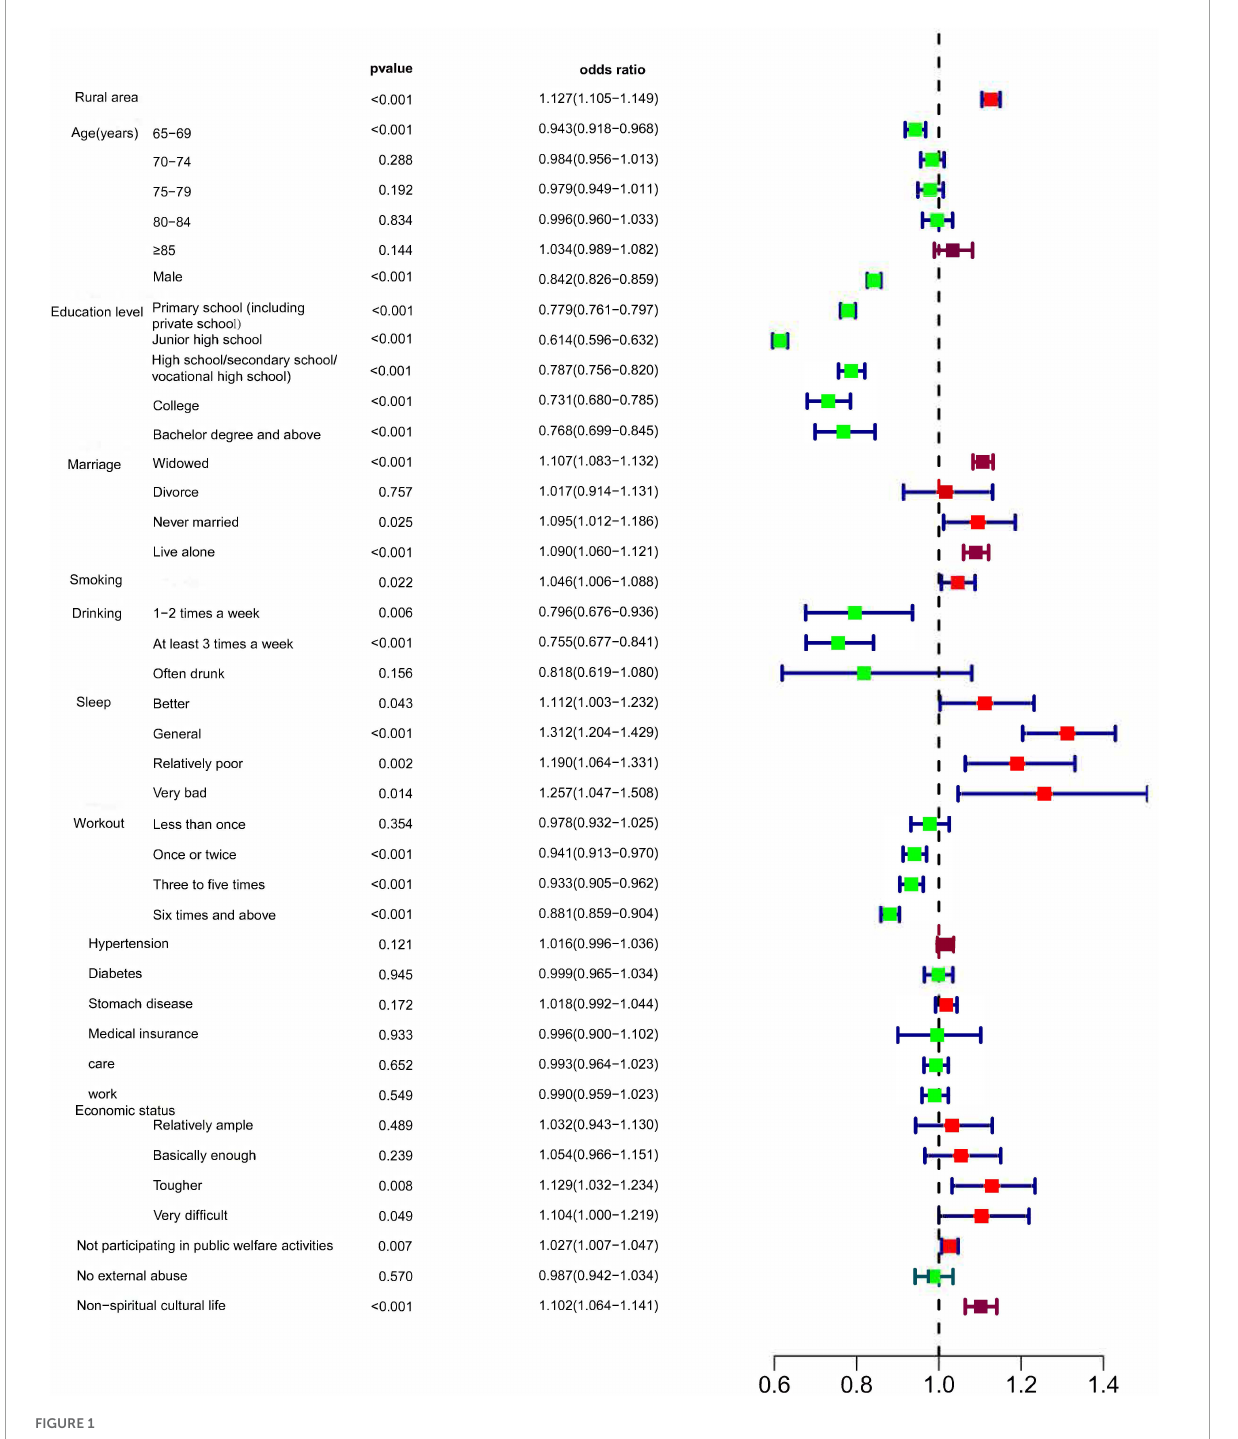
3 – Supplementary Table 1 ). The results show that female rural residents, low literacy levels, smoking,